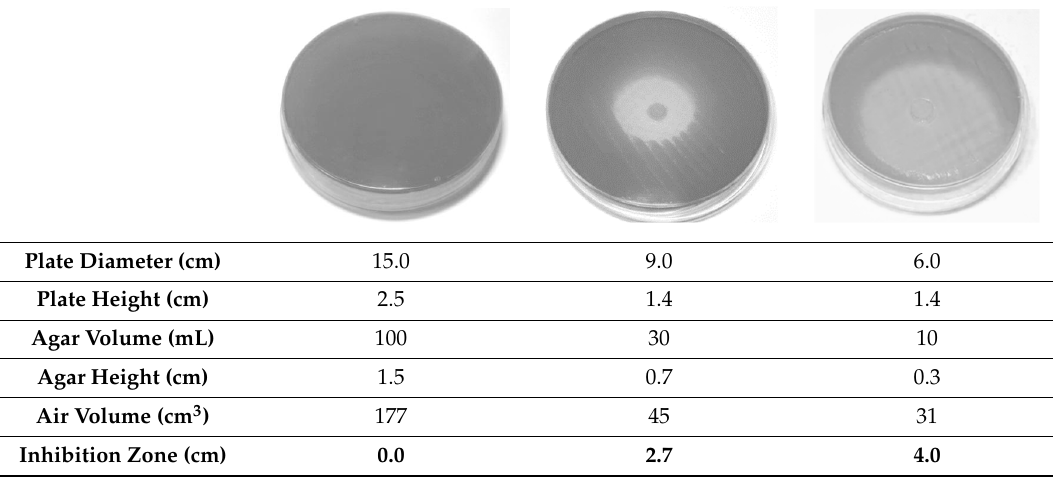
Table 1. Dependence between Petri dish diameter and size of S. aureus growth inhibition zone after